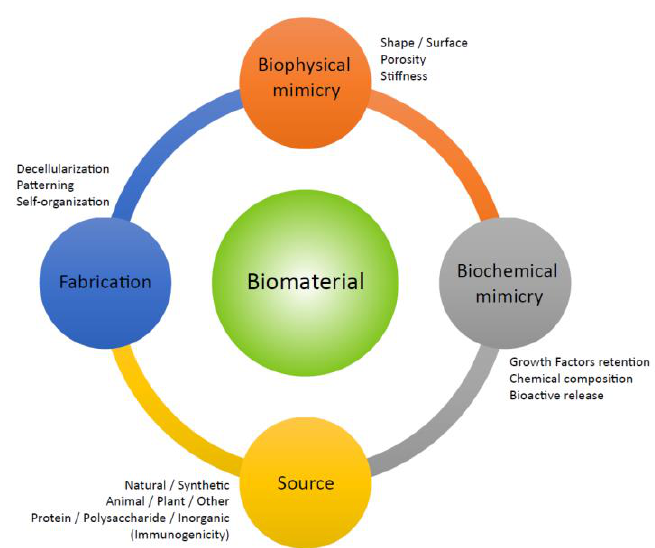
Figure 4. Schematic representation of the criteria to consider during biomaterial design. The properties of the biomaterial will be dependent on both biophysical and biochemical cues, strictly connected to the source of the material and its fabrication methods.